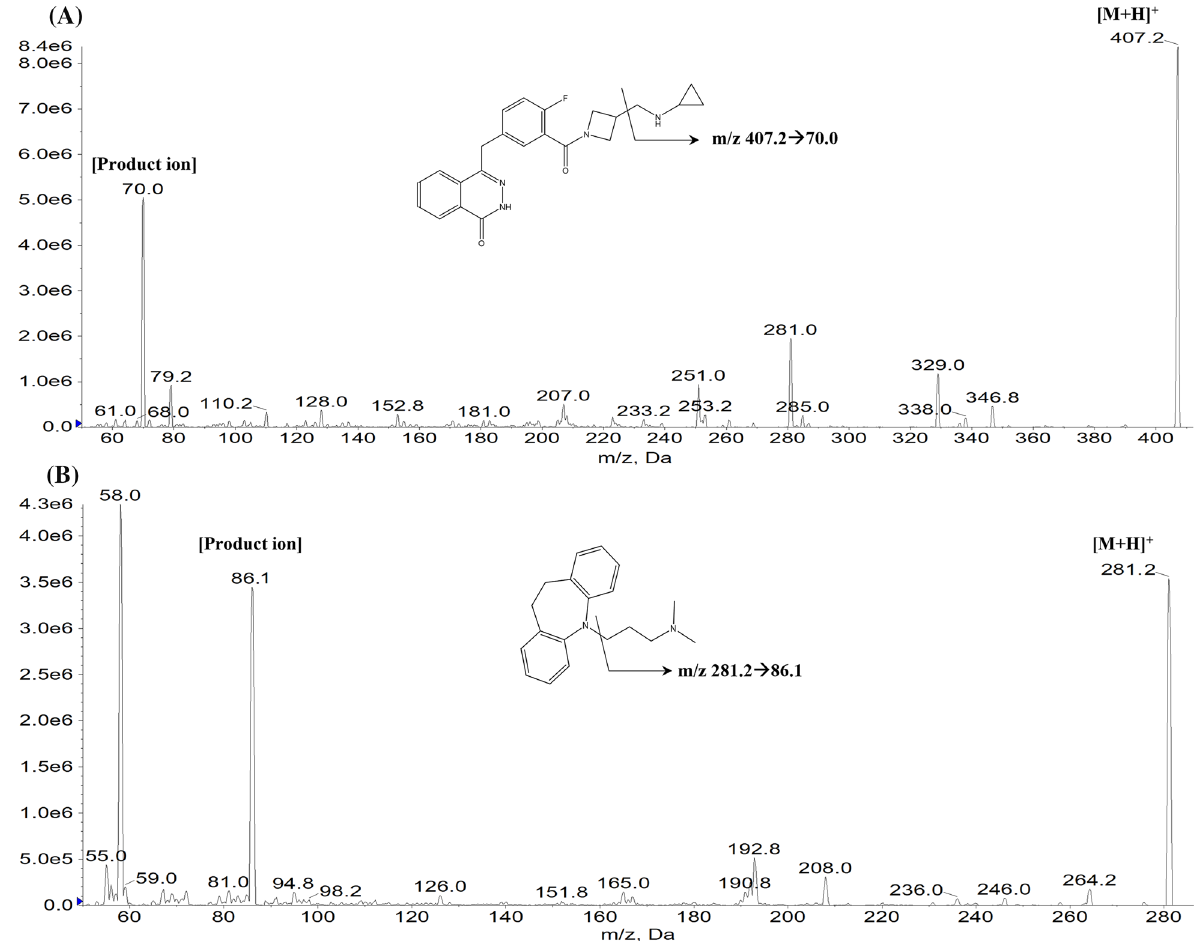
Fig. 1 Structures and product ion scan spectra of A VEN and B IS (i.e.,